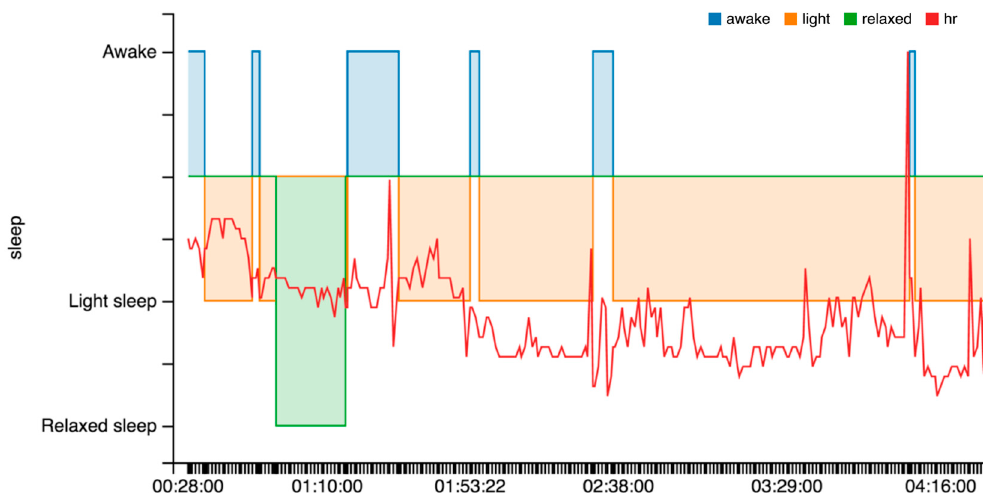
Figure 13. Sleep segments in Microsoft.